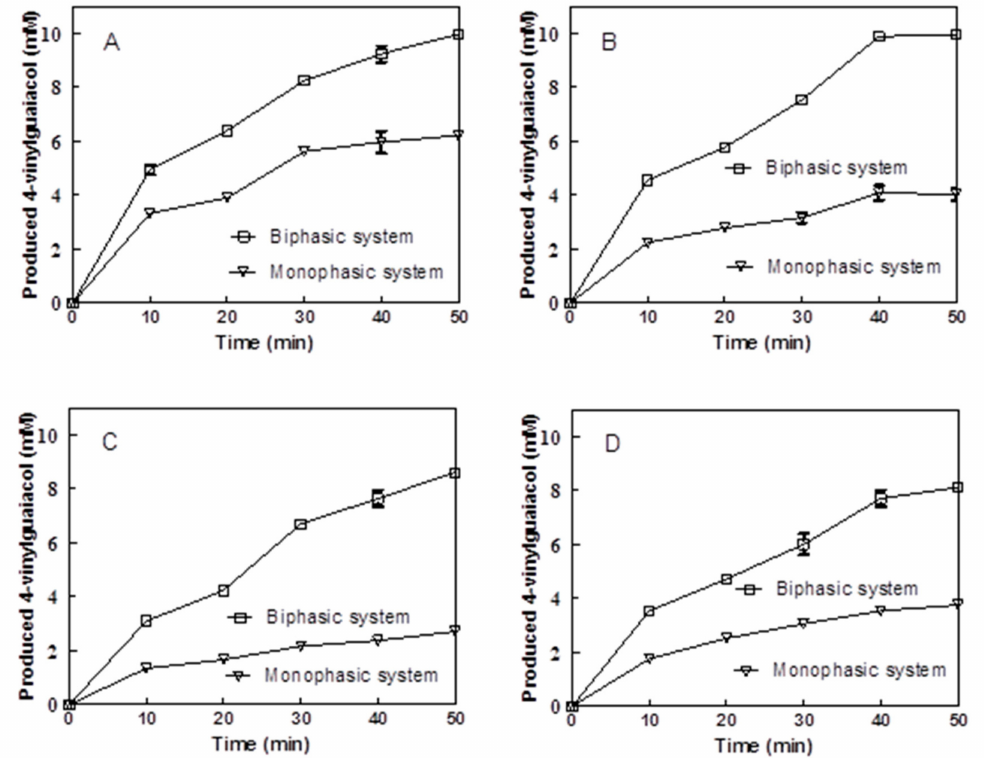
Figure 6. Bioconversion of ferulic acid (FA) in monophasic and biphasic systems with four di ff erent surface-displayed cells. ( A , B ) BL21(DE3) cells and BL21 (DE3) pLysS cells carrying a pET22b-pelblpad vector, respectively. ( C , D ) BL21(DE3) cells and BL21 (DE3) pLysS cells carrying a pET22b-gdsllpad vector,